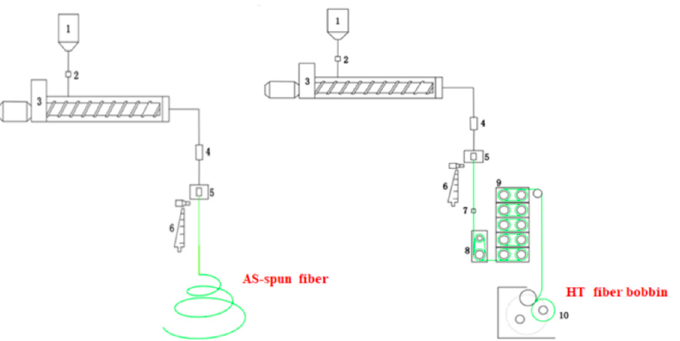
Figure 1. Schematic assembly of the high-tenacity polyamide fiber melt-spinning unit. 1. Hooper, 2. Feeding valve, 3. Extruder, 4. Gear bump, 5. Spinning pack, 6. Cooling system, 7. Oil bump, 8. GR1, 9. GR2, 10. Roller.